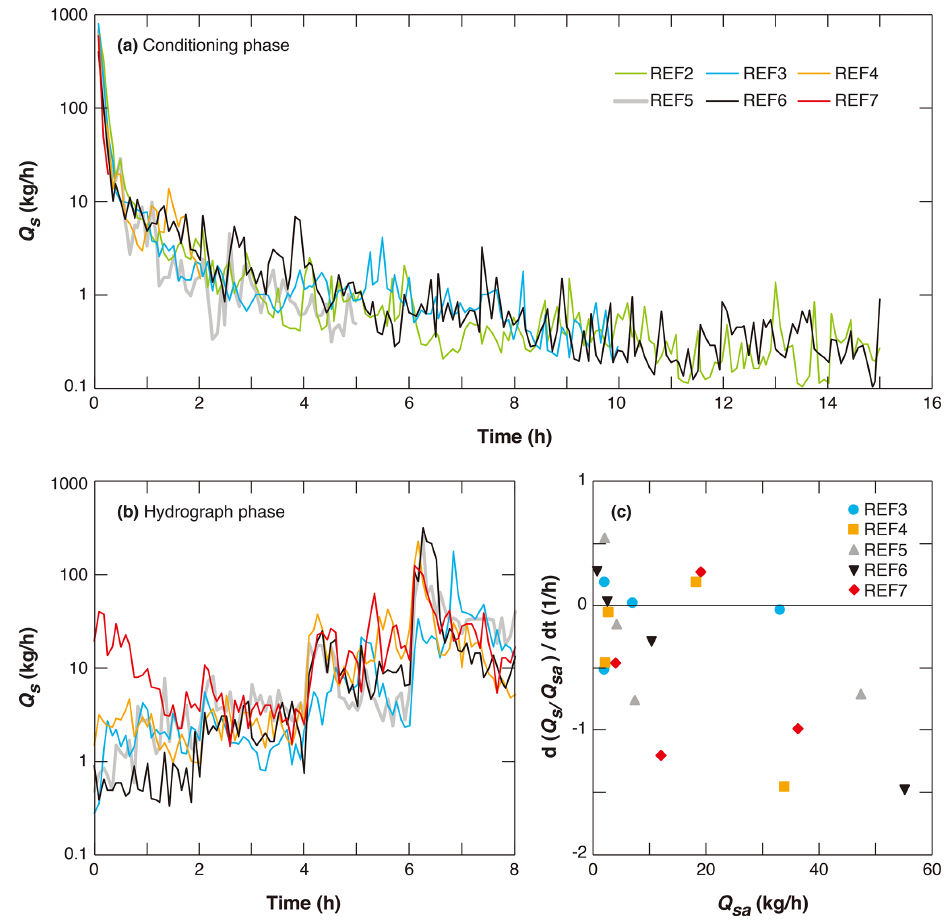
Figure 6. Instantaneous sediment transport rate measured by the light table during (a) the conditioning phase and (b) the hydrograph phase. (c) Intra-step temporal change rate of Q s normalized against Q sa for each hydrograph step. Q s is the sediment transport rate, and Q sa is the averaged sediment transport rate of a given hydrograph